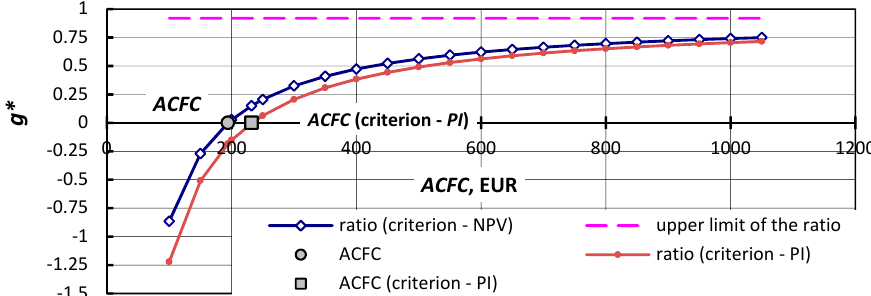
Figure 5. The dependence of the ratio of alternative fuel price to conventional fuel price on the annual conventional fuel consumption cost (criterion— PI ).